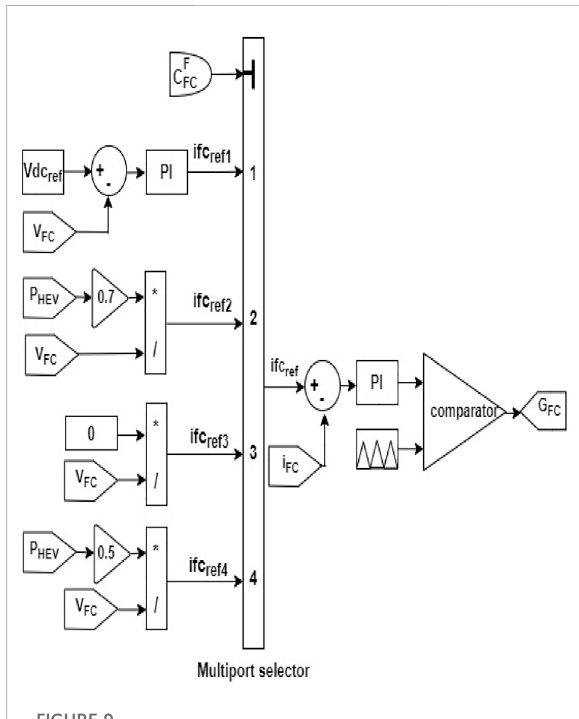
FIGURE 9 FC control scheme. If C F FC equals 1, i fc , ref (cid:2) i fc , ref1 , and the FC will ensure DC bus